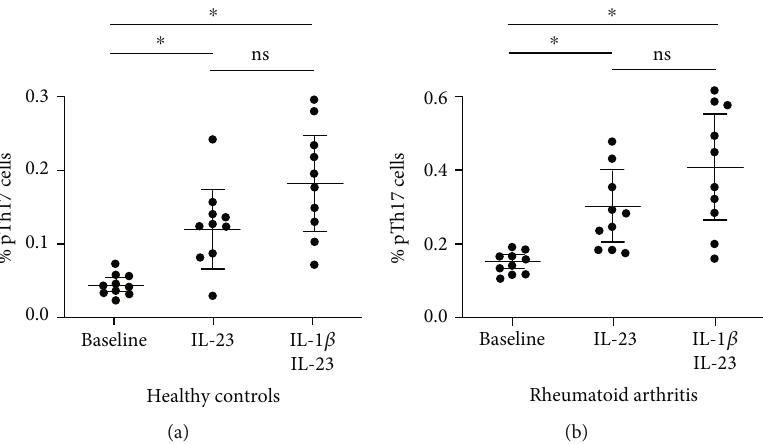
Figure 4: In vitro induction of pathogenic Th17 cells. PBMC from healthy controls and patients with rheumatoid arthritis were incubated in the presence or not of IL-23 or IL-1 β plus IL-23 and then the percent of pathogenic Th17 (pTh17) cells, referred to total lymphocytes, and were analyzed by fl ow cytometry, as described in Material and Methods. Data correspond to the arithmetic mean and SD of ten separate experiments. ∗ p < 0 : 05 . ns: nonsigni fi cant (Kruskal-Wallis test with Dunn ’ s